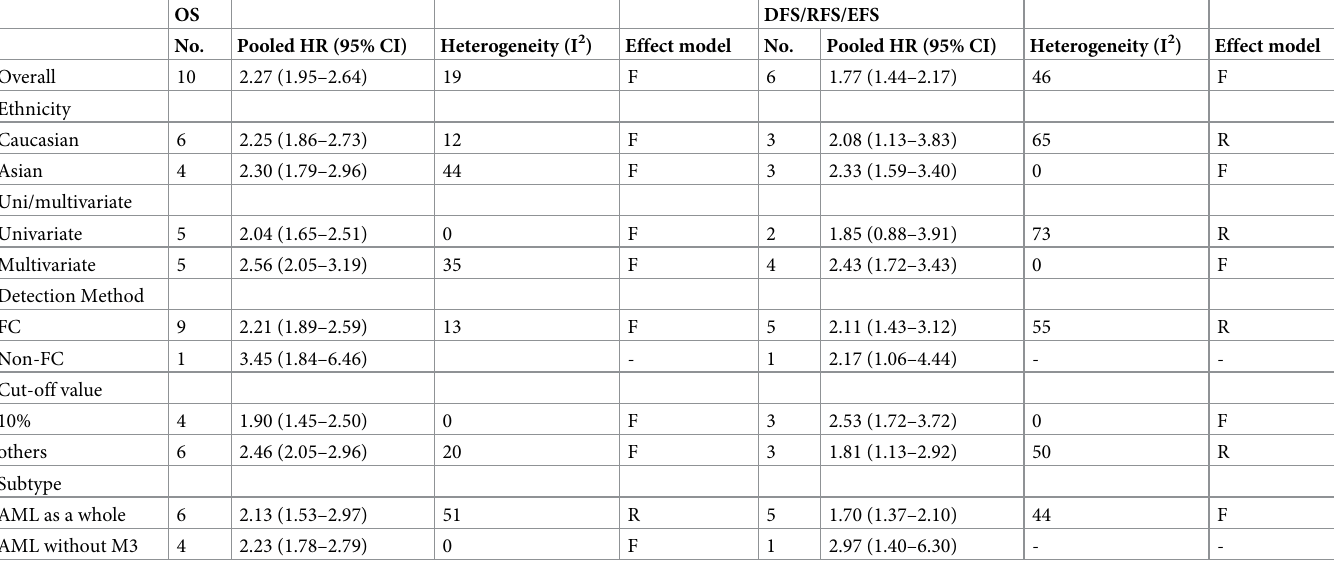
Meanwhile, subgroup analyses obtained similar results (Table 2). Hazard ratios (HRs) for each trial are represented by the squares, and the horizontal lines crossing the square stand for the 95% confidence intervals (CIs). The diamonds represent the Table 2. Results of overall and subgroup analyses in the prognostic